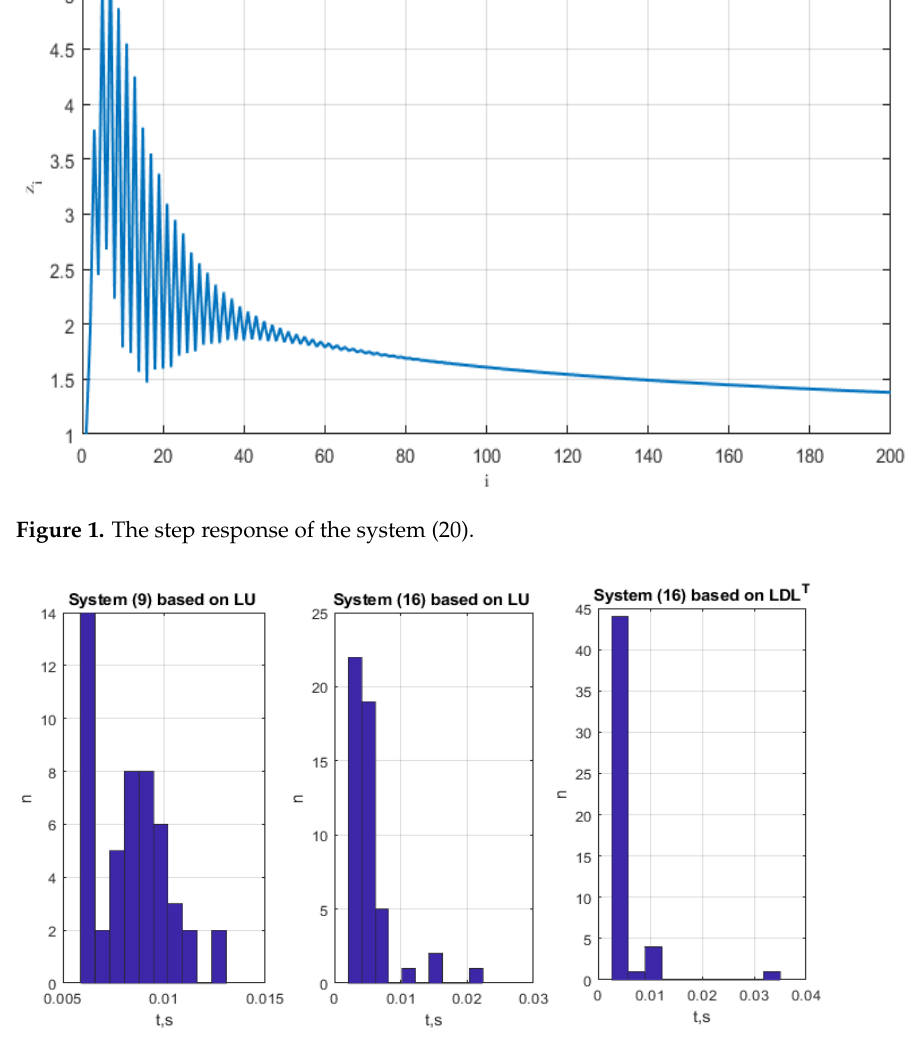
Figure 2. Histogram of the decision time. Table 2. The mean values of the decision time and their standard deviations.